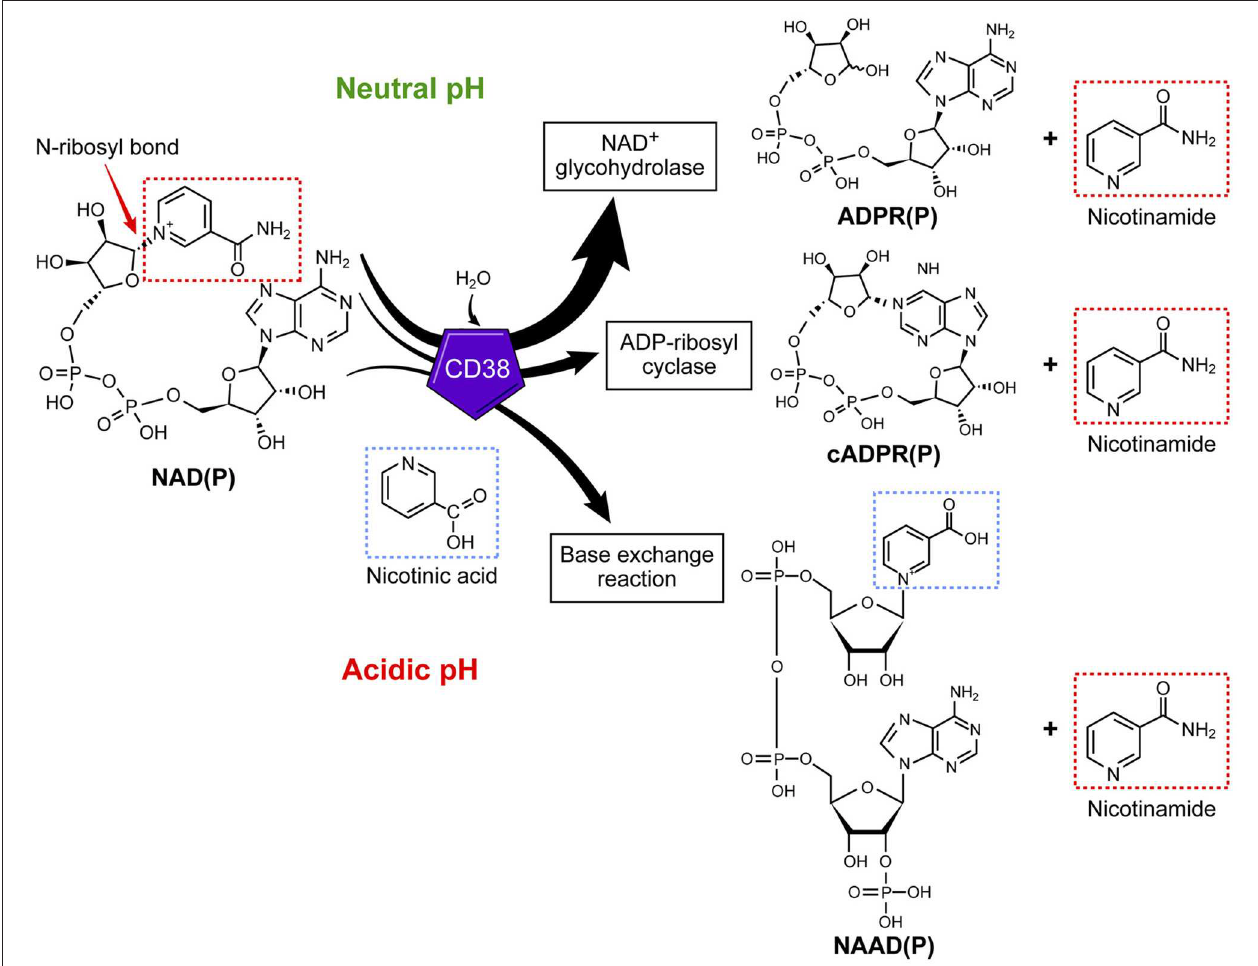
FIGURE 2 | CD38 is primarily an NAD + glycohydrolase, which degrades nicotinamide nucleotides . In addition to the NAD + glycohydrolase activity, CD38 exhibits inefficient ADP-ribosyl cyclase activity and mediates a base-exchange of vitamin B3 bases in the presence of excess nicotinamide